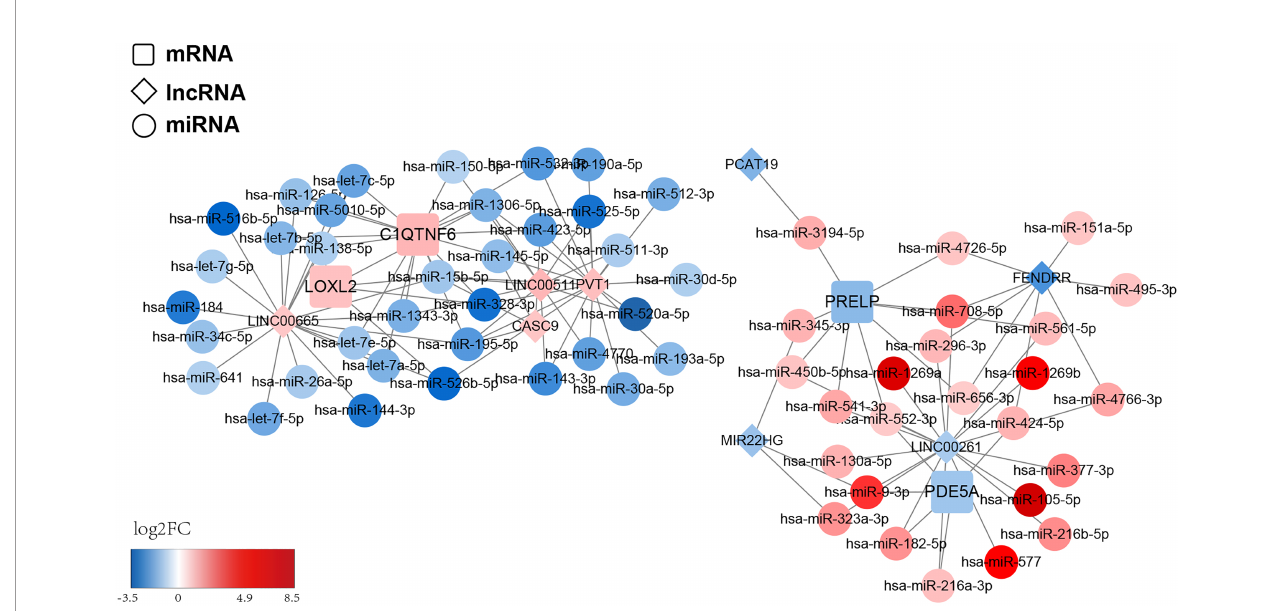
FIGURE 10 | ceRNA regulatory network of the risk model gene. The squares represent model genes, the diamonds represent lncRNA, and the circles represent microRNAs. Different colors represent different log 2 FC values. We predict the prognostic gene – DE-miRNAs – DE-lncRNAs relationship pairs and obtained a ceRNA network based on 4 prognostic genes, which covered 72 nodes and 116